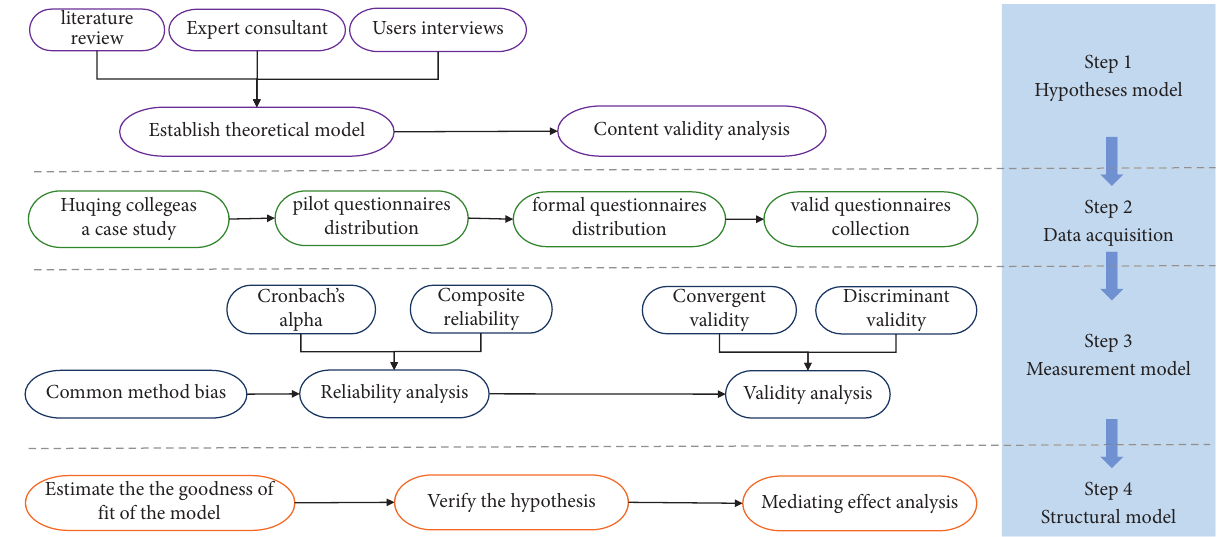
Figure 4: Analysis procedures of the